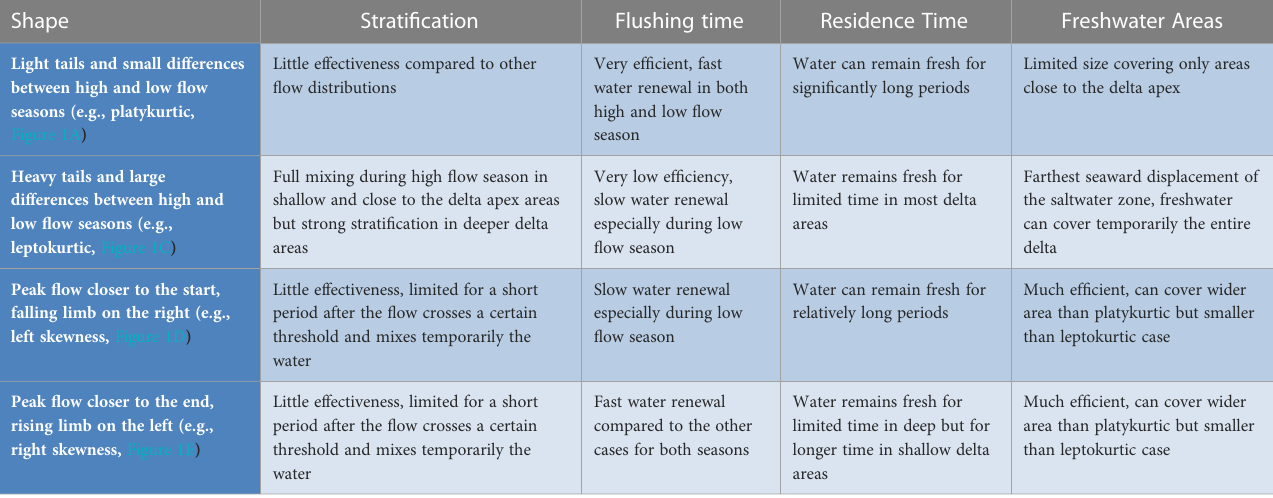
TABLE 4 A summary of the effects in strati fi cation, fl ushing and residence times and freshwater areas caused by the main characteristics of the fl ow regimes under consideration.